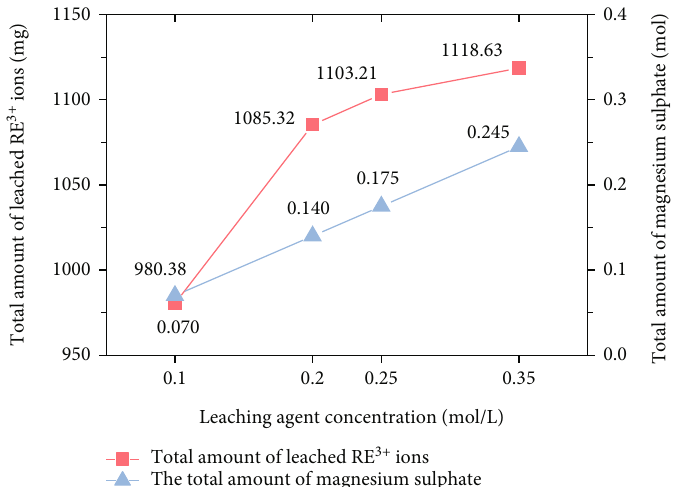
Figure 15: The total amount of leached RE 3+ ions and the total amount of magnesium sulphate under di ff erent leaching agent